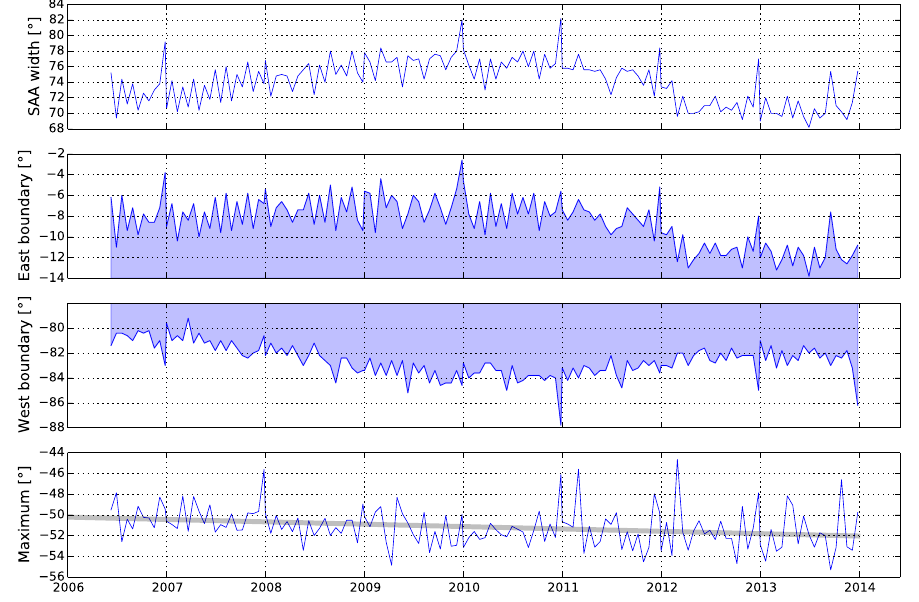
Figure 4. (top) zonal width of the SAA, defined as the region where more than 10% of profiles between 45 ◦ S and 10 ◦ S are affected by large noise. (second and third rows) east and west boundaries of the region. (bottom) longitude of the maximum fraction of noisy profiles, with a linear regression in grey.